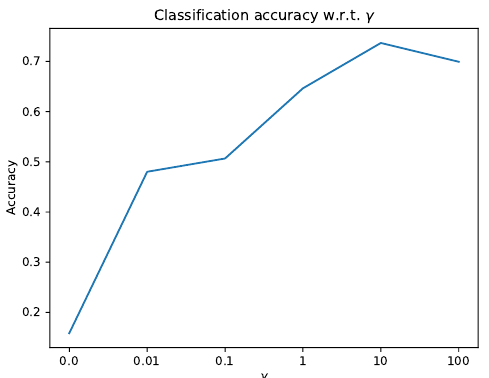
Figure 7. Classification performance of the 3D Conditional Generative Adversarial Network (3D CGAN) classifier trained using the Wasserstein loss function shown in (4) and (5) with different values of γ .